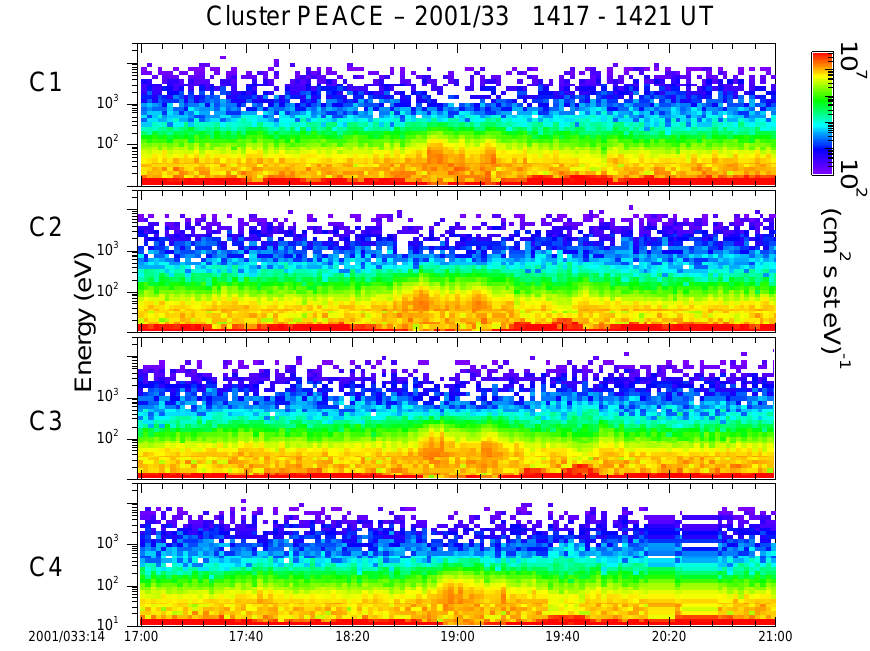
Fig. 6. As Fig. 4, for the period from 14:17–14:21 UT. An enhancement in magnetosheath electrons is again evident in this period. The onset is relatively rapid at all 4 spacecraft, but as in the previous example, C4, located deeper into the magnetosphere, observes a less structured